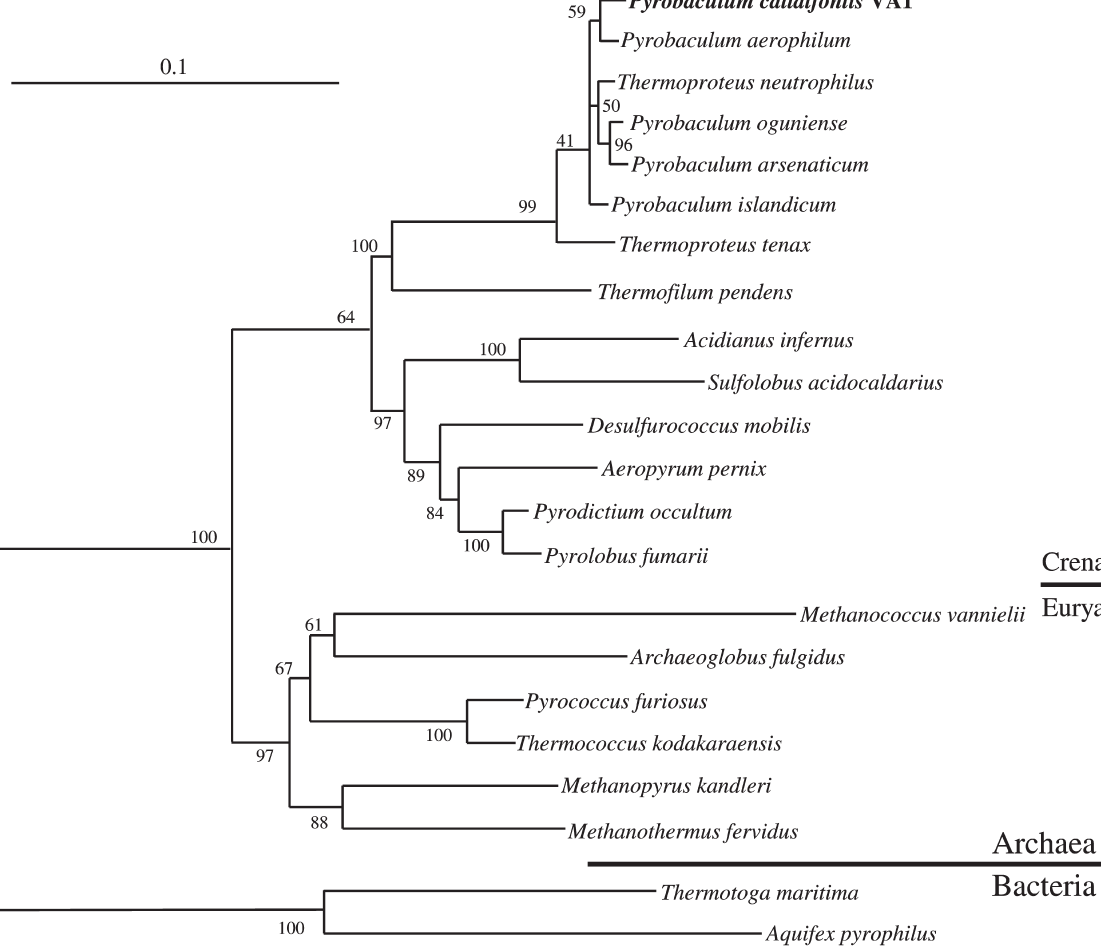
Figure4. Phylogenetictreebased on 16S rRNA gene sequences showing the positionof Pyrobaculum calidifontis (strainVA1). Multiplesequence alignments were performed with ClustalW. Tree topology and evolutionary distance estimations were performed by the neighbor-joining method. Scale bar indicates 10 substitutions per 100 nucleotides. Numbers represent bootstrap probabilities (%). The accession numbers are as follows: Acidianus infernus , D85505; Aeropyrum pernix , AB008745; Aquifex pyrophilus , M83548; Archaeoglobus fulgidus , Y00275; Desulfurococcus mobilis , M36474; Methanococcus vannielii , M36507; Methanopyrus kandleri , M59932; Methanothermus fervidus , M59145; Pyrobaculum aerophilum , L07510; Pyrobaculum arsenaticum , AJ277124; Pyrobaculum calidifontis , AB078332; Pyrobaculum islandicum , L07511; Pyro- baculum oguniense , AB029339; Pyrococcus furiosus , U20163; Pyrodictium occultum , M21087; Pyrolobus fumarii , X99555; Sulfolobus acid- ocaldarius , D14876; Thermococcus kodakaraensis , D38650; Thermofilum pendens , X14835; Thermoproteus neutrophilus , AB009618; Thermo- proteus tenax , M35966; and Thermotoga maritima ,